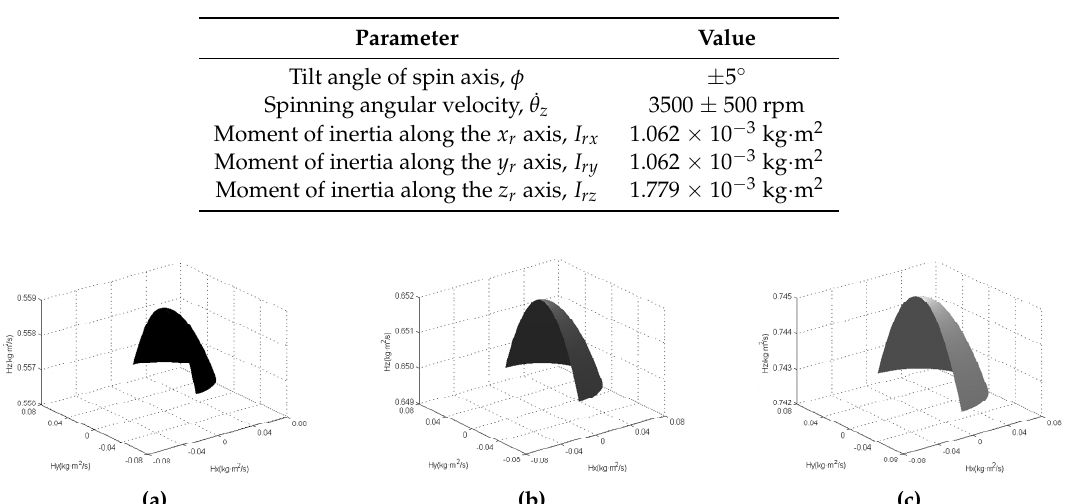
Table 1. Physical parameters of the GyroWheel rotor.